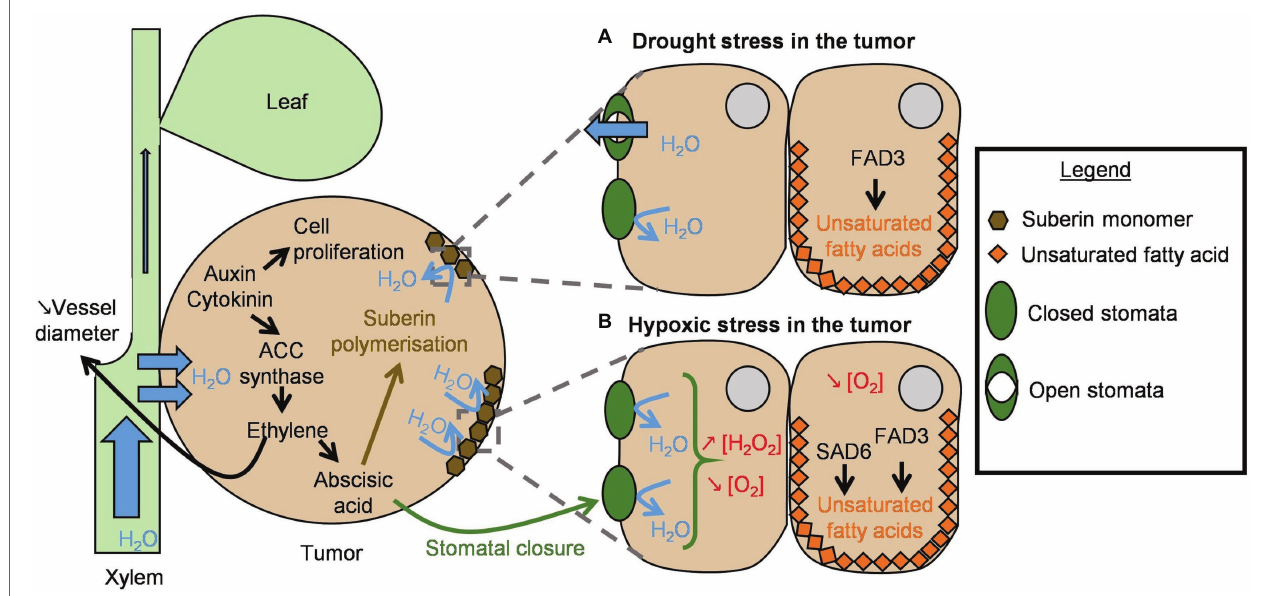
FIGURE 1 | Schematic representation of the plant reactions to the stresses caused by tumor development. T-DNA integration into the plant genome induces auxin and cytokinin production. High concentrations of these two phytohormones accelerate cell proliferation and tumor growth. ACC synthase expression is also induced and triggers ethylene production. Ethylene has two main roles in the tumor: it reduces plant vessel diameter around the tumor to ensure its hydration, and it triggers abscisic acid synthesis. The latter induces the polymerization of suberin that forms a protective layer around the tumor. (A) Drought stress in the tumor: under drought stress, FAD3 produces α -linolenic acid, an unsaturated fatty acid, to maintain lipid membrane integrity. (B) Hypoxic stress in the tumor: when the drought stress is more severe (i.e., in old tumors), abscisic acid triggers stomatal closure. This implies H 2 O 2 production and leads to a decreased oxygen rate. Under low oxygen, SAD6 also contributes to the production of unsaturated fatty acids to maintain lipid membrane integrity in the transformed